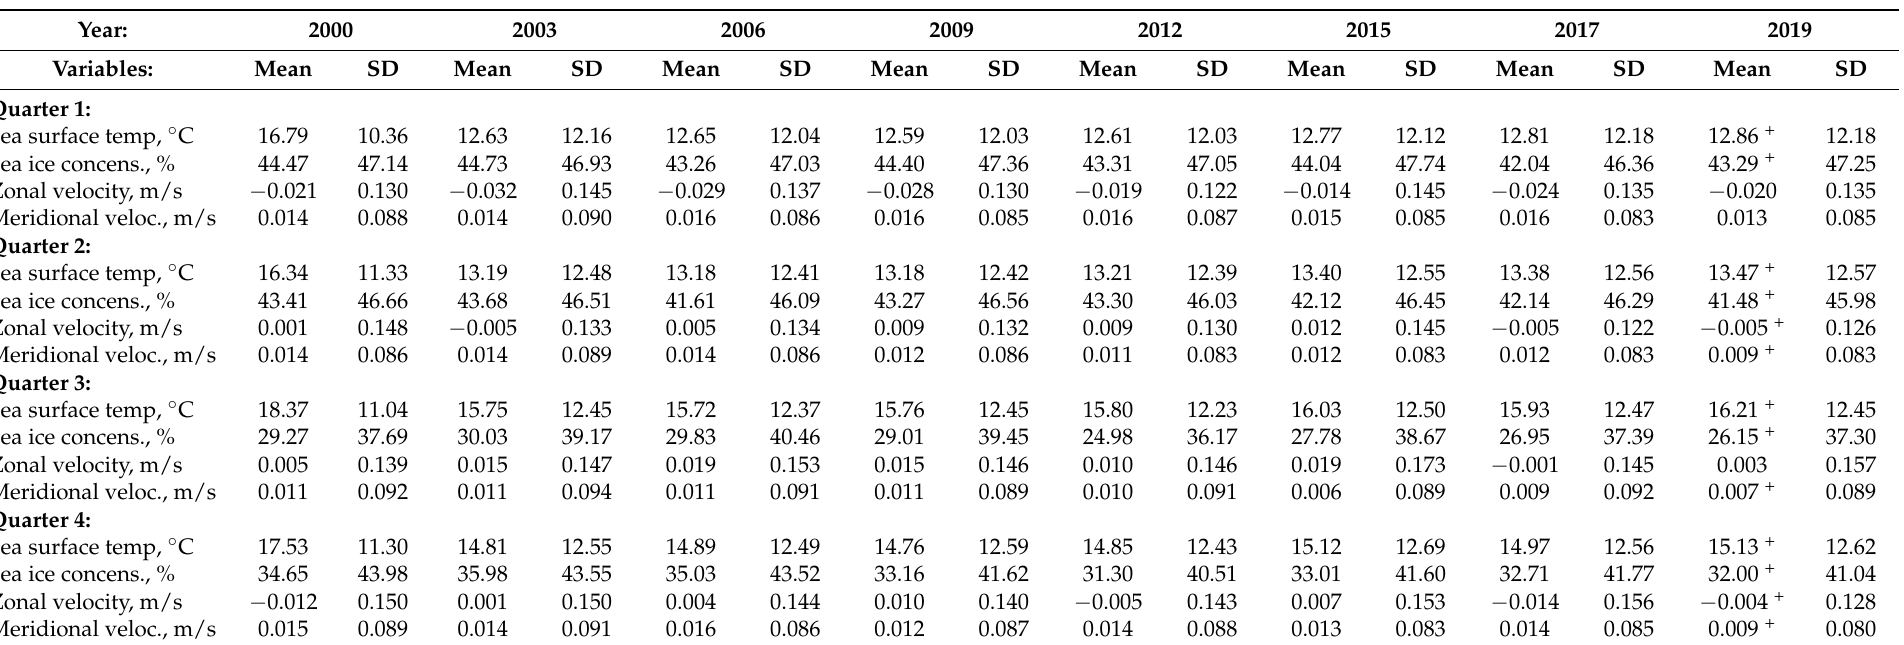
Table 1. Sample means and standard deviations of quarterly sea surface temperatures, sea ice concentrations, and zonal and meridional ocean current velocities